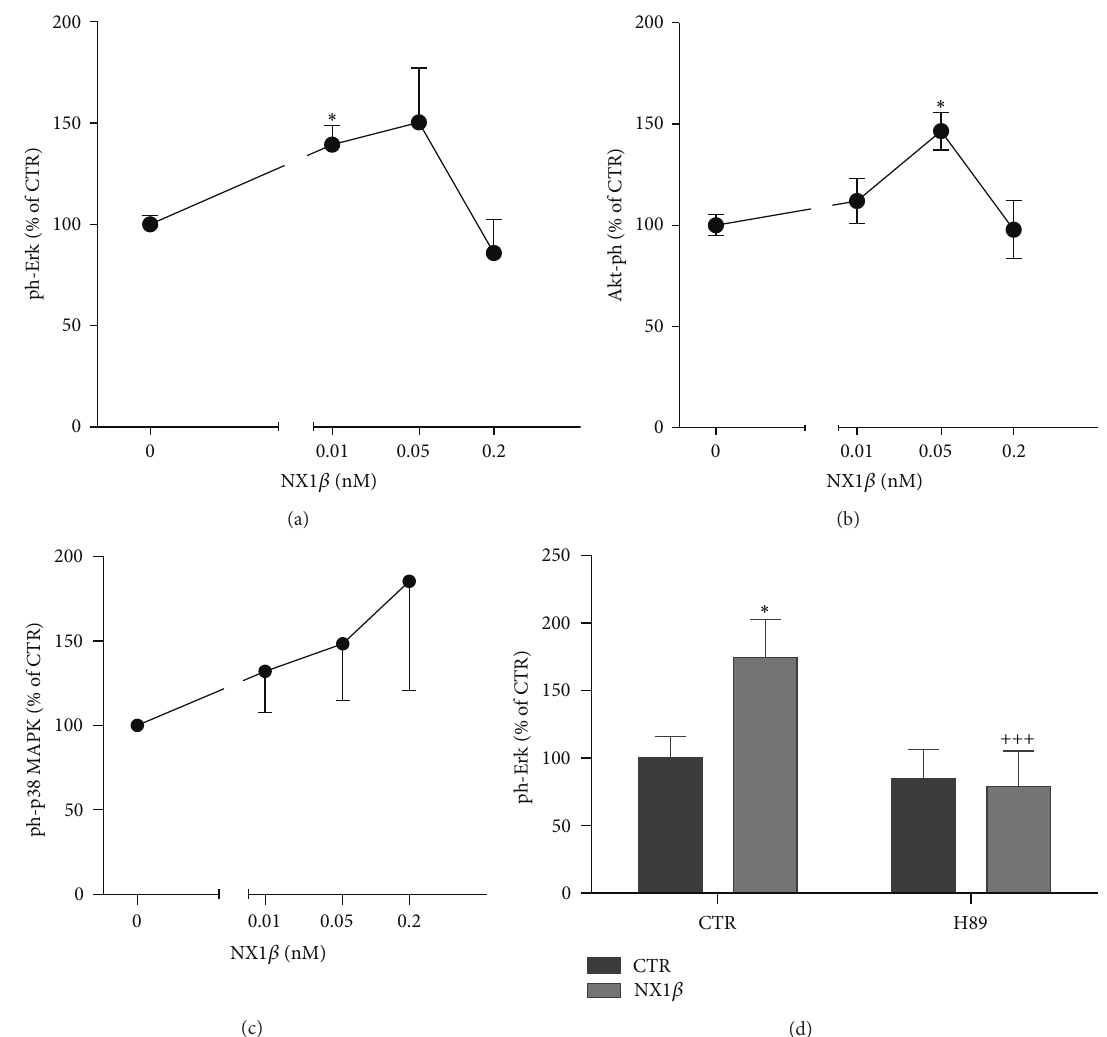
Figure 6: NX1 𝛽 activates ERK1/2 and Akt kinases. Cortical neurons were grown for 8 days, subsequently treated with different concentrations of recombinant NX1 𝛽 for 5 min, and further immunoblotted for the detection of (a) ERK1/2, (b) p38 MAPK, and (c) Akt. (d) Effect of the PKA inhibitor H89 on NX1 𝛽 -induced ERK1/2 phosphorylation. The results from 𝑛 ≥ 4 experiments are expressed as a percentage ± SEM. ∗ 𝑃 < 0.05 , compared with the untreated control set at 100%.